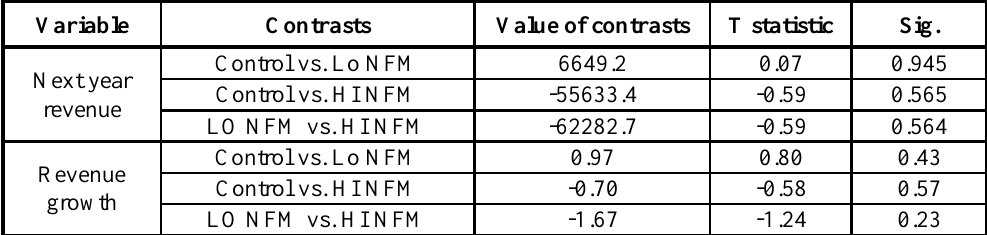
Table 3. Contrasts test (non-financial information alone and low knowledge)